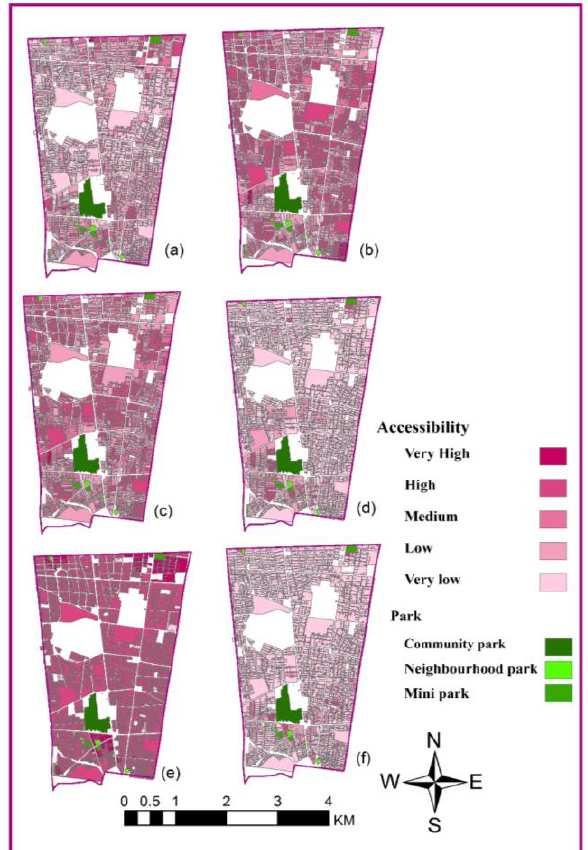
Figure 2. Output map of each method: (a) Covering method, (b) Minimum distance method, (c) Average distance method, (d) Proximity method, (e) Two-step floating catchment area, and (f) Gravity-based two-step floating catchment area